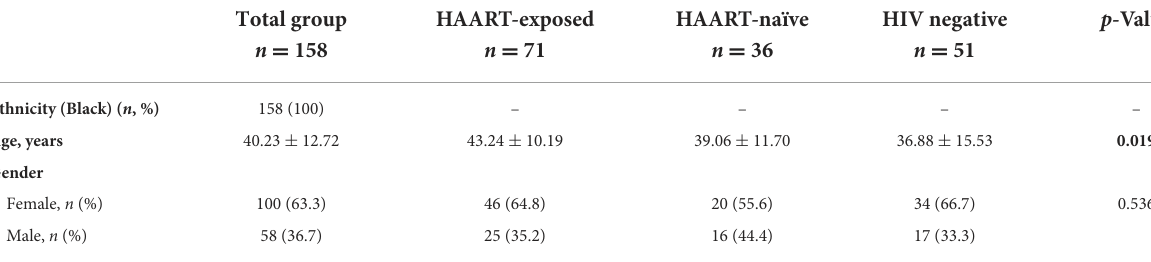
TABLE 1 Demographics of the study participants.